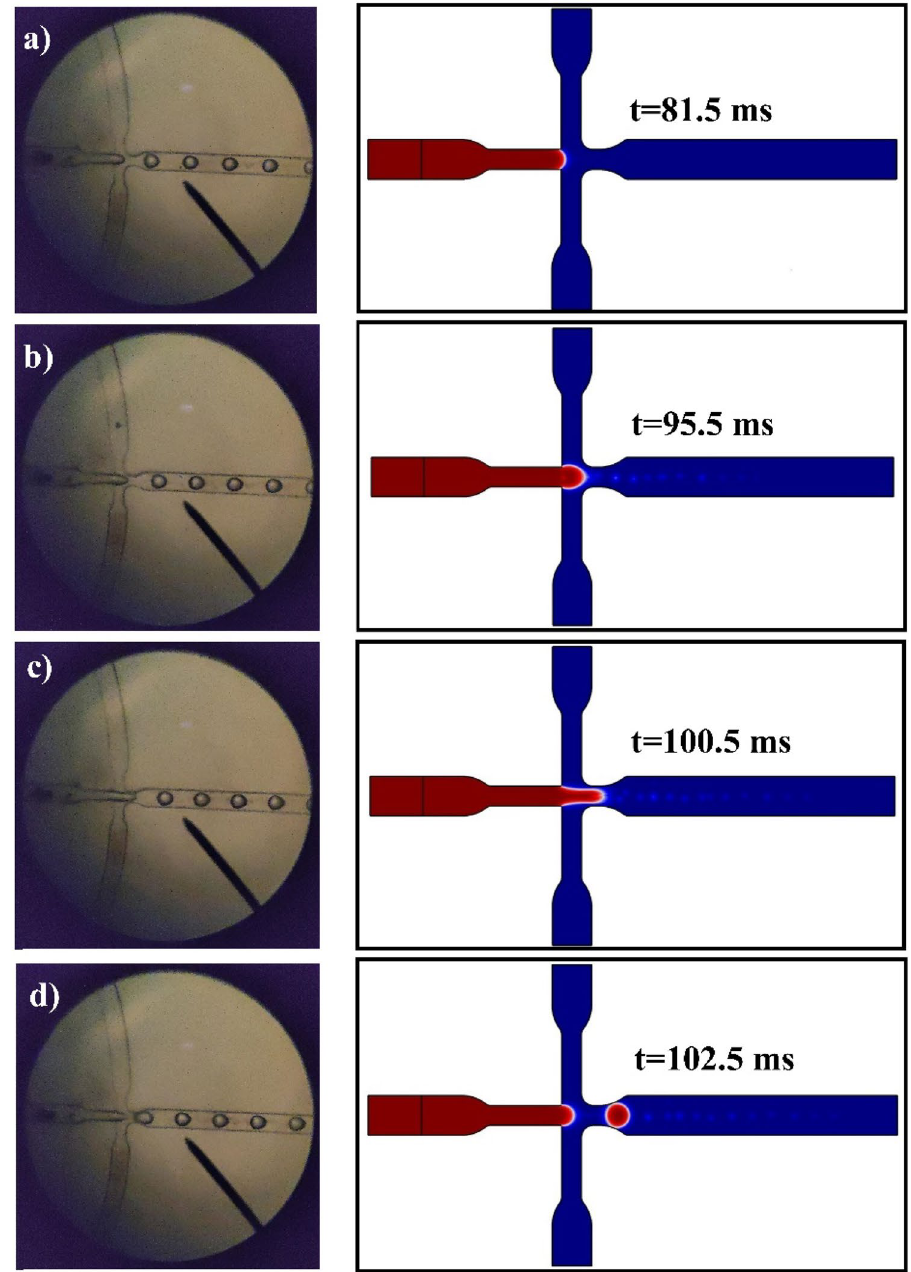
Figure 2. The microscopy and two-dimensional images of mechanism formation of CS + DOX microgel droplet injunction, ( a ) lag stage, ( b ) filling stage, ( c ) necking stage, ( d ) detachment. The CS + DOX and vegetable oil phase velocities were adjusted at 3.3 and 11.1 mm/s. The Concentration of CS and DOX are 0.2% and 13.75 (µg/ ml),